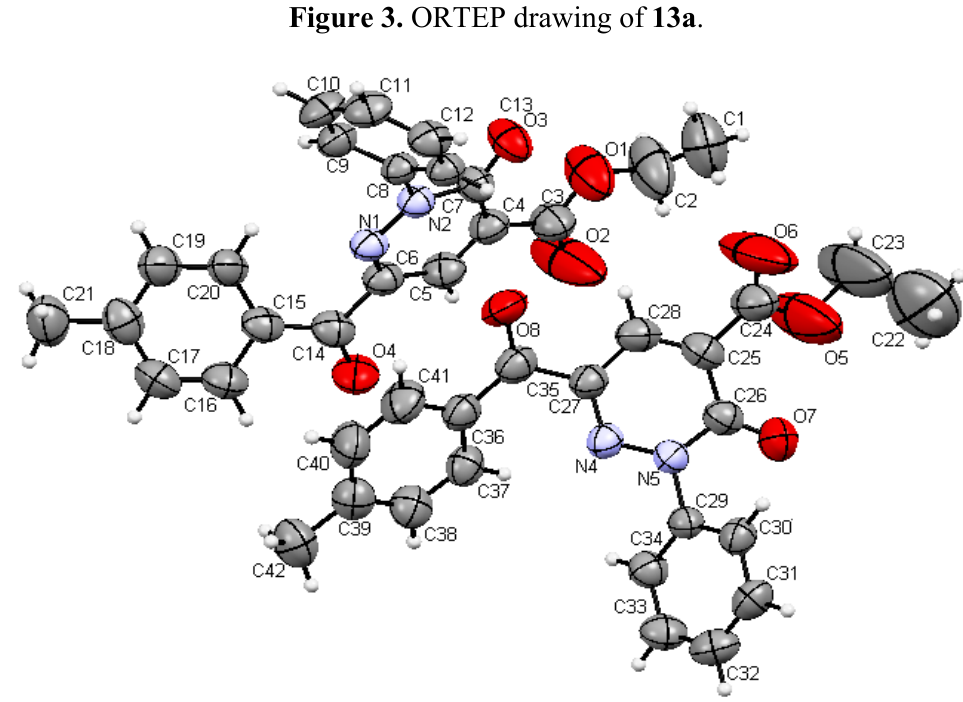
Figure 3. ORTEP drawing of 13a